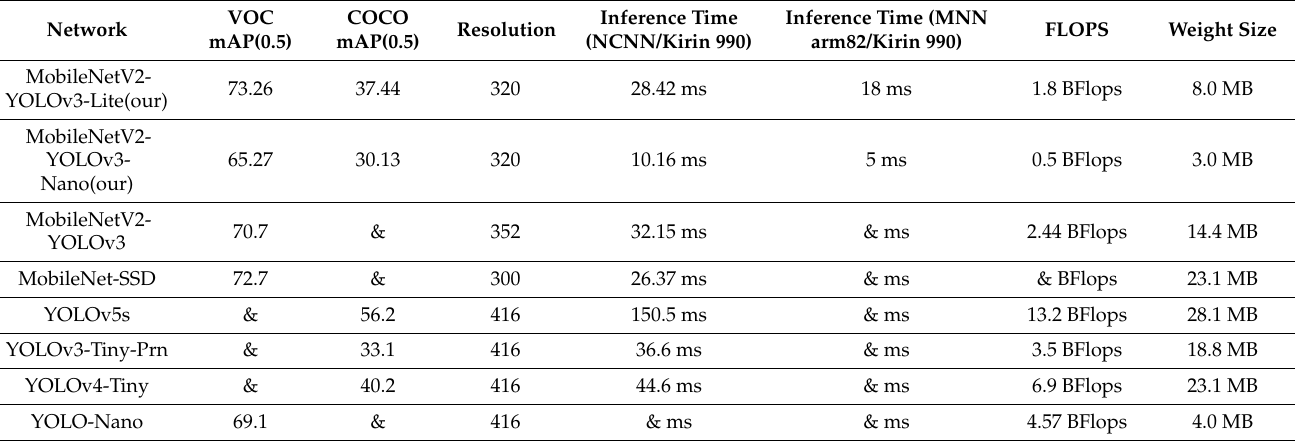
Table 2. Mobile-net and YOLO algorithm performance test